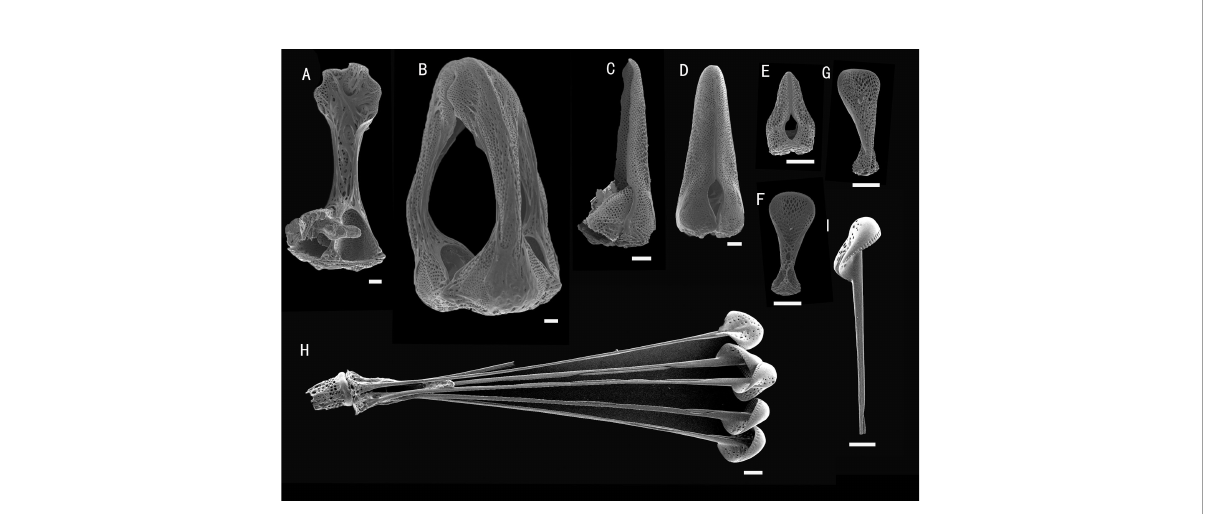
FIGURE 12 Araeosoma bidentatum , MBM286957. SEM images of pedicellariae. (A, B) Large tridentate pedicellaria: (A) individual valve (B) head. (C, D) Straight side bidentate pedicellaria: (C) individual valve (D) head. (E) Rostrate bidentate pedicellaria. (F, G) Valves of triphyllous pedicellariae. (H, I) Dactylous pedicellaria. Scale bar , 100 m